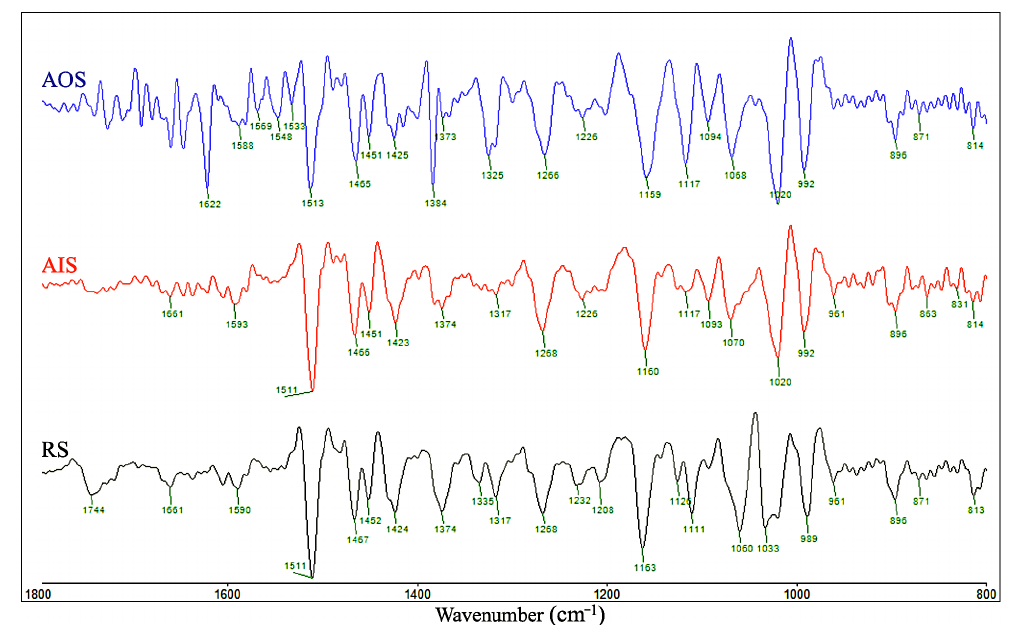
Figure 5. FT ‐ IR spectra of RS (red), AIS (yellow), and AOS (blue).